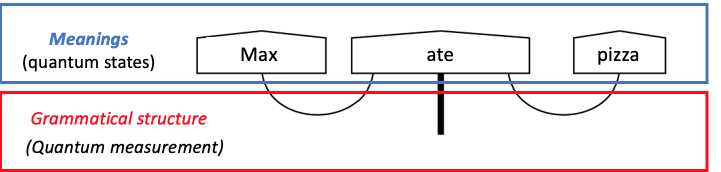
Figure 2. Diagrammatic notation showing how word meaning can be interpreted as quantum states and grammatical structure as quantum